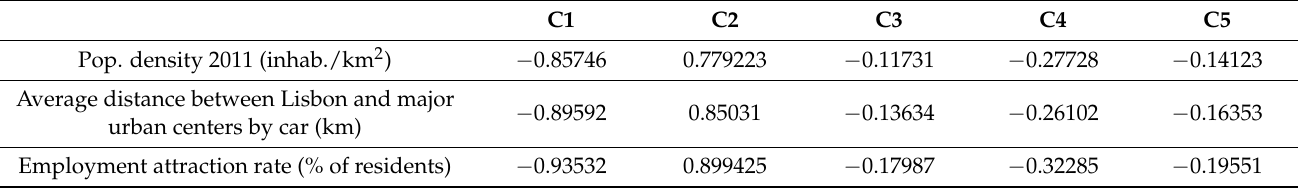
Table A2. Pearson’s correlation between cluster scores and socioeconomic variables by PCA